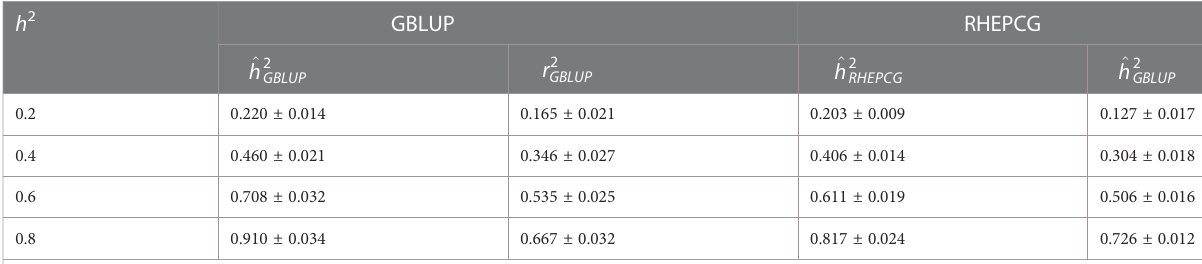
TABLE 3 Comparison of the estimated heritability and predictive accuracy of GBLUP and RHEPCG at different levels of heritability based on 10 simulations in the Arabidopsis thaliana F2 population. h 2